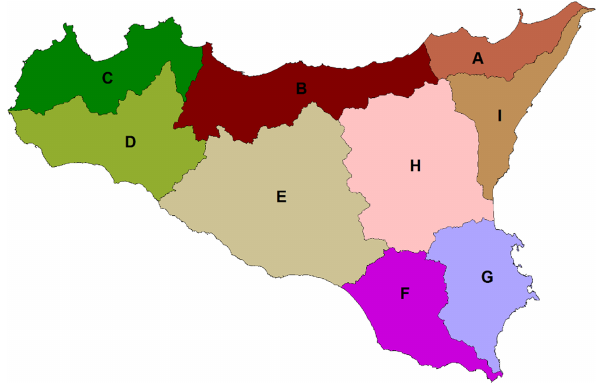
Figure 1. Layout of Alert Zones for